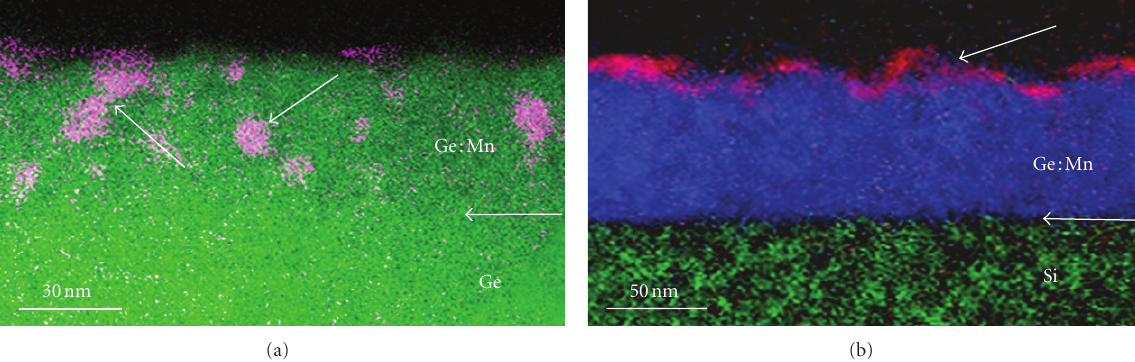
Figure 6: (a) and (b) are the corresponding EELS map of GeMn films on Ge and Si, respectively. (a) Reproduced from [11].